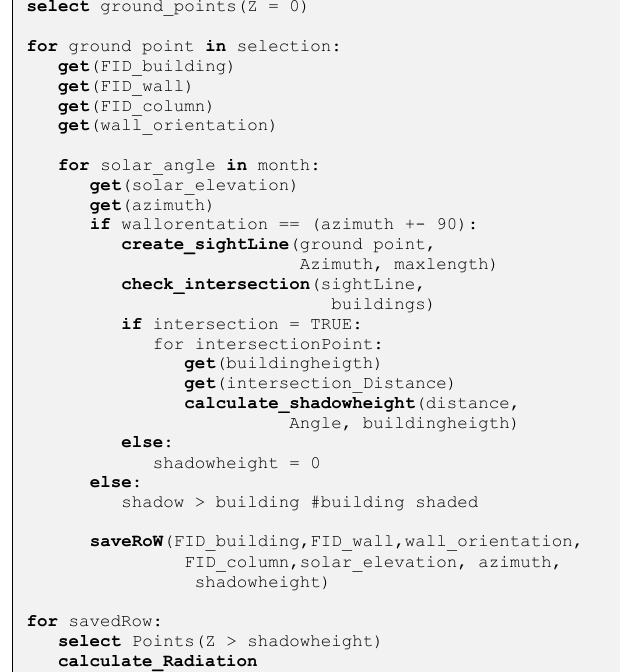
Figure 1. Pseudocode for the determination of radiation time and angle for single observer points.